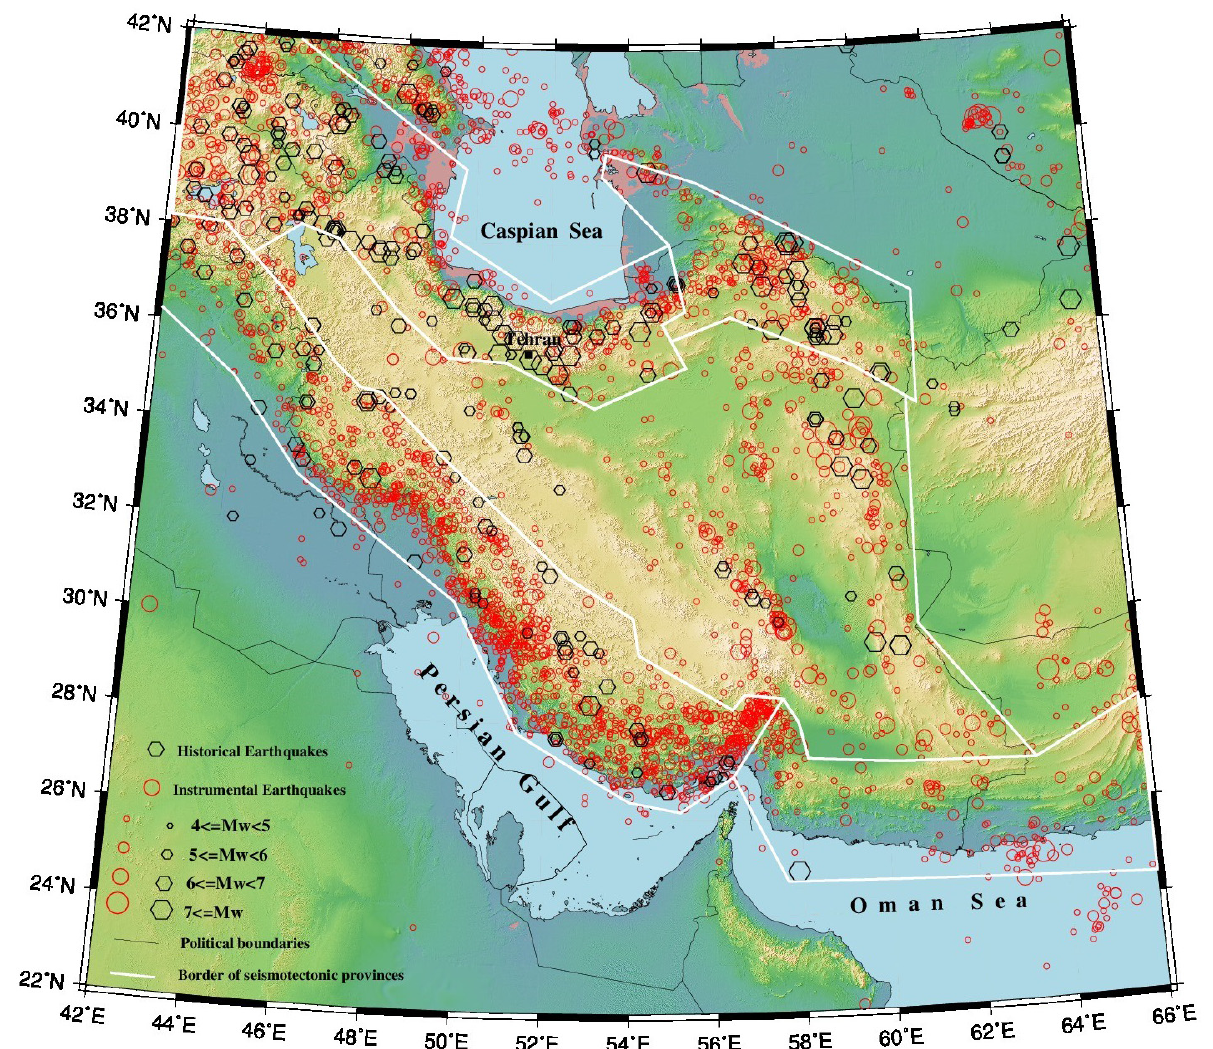
Figure 12. Epicenter distribution of historical (pre–1900) and declustered earthquakes (1900–2012) in Iran and the adjacent regions.